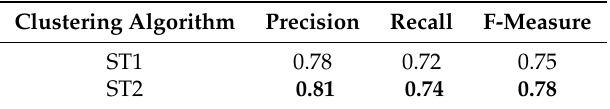
Table 6. Comparision of the clustering approach by analyzing orphan events (ST1) and not analyzing them